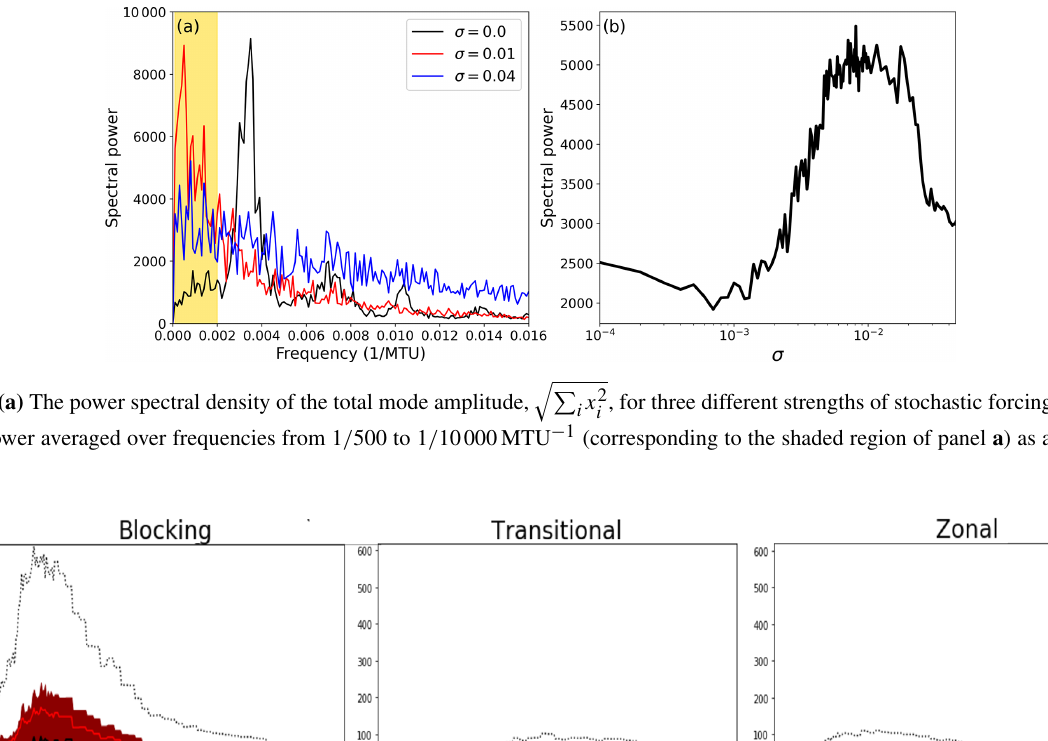
Figure 6. The distribution of blocking regime lifetimes, as a function of stochastic forcing amplitude. Shaded regions mark the interquartile range, with the thick black line showing the median and the red line the mean. Dotted black lines show the 0th and 95th percentiles of the